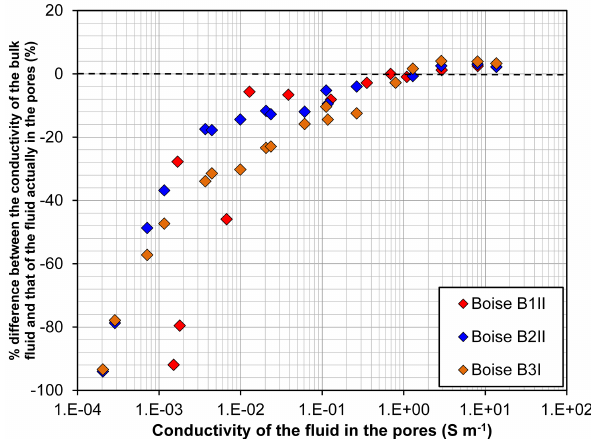
Figure 6. Percentage difference between the conductivity of the fluid in the pores and that of the bulk fluid originally used to sat- urate the rock as a function of the resistivity of the fluid in the pores for three samples of Boise sandstone.